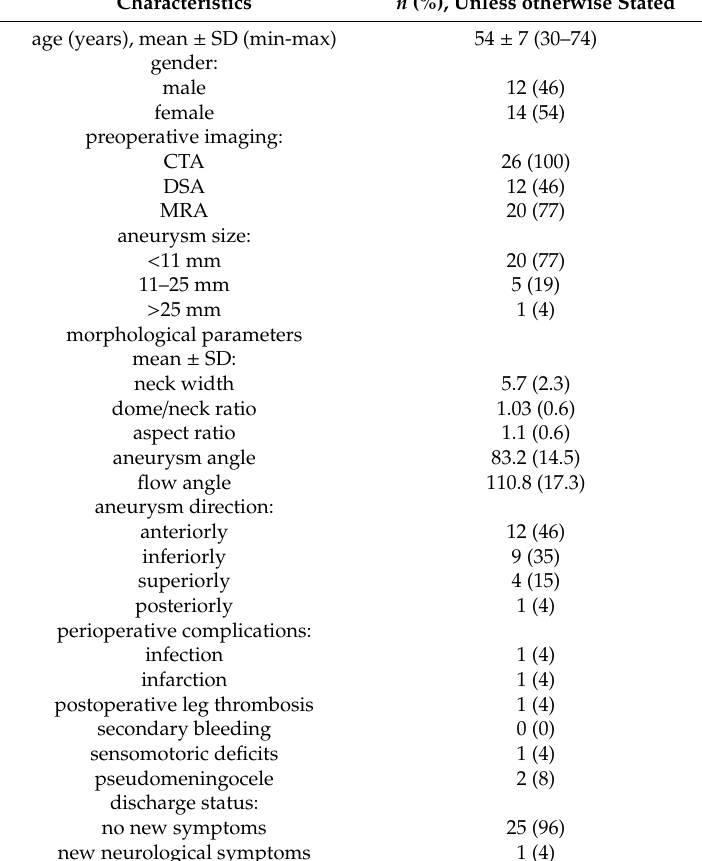
Table 2. Patient- and disease-related data of included patients with unruptured ACoA aneurysms operated with aneurysm clipping. One or more complications per patient were possible.